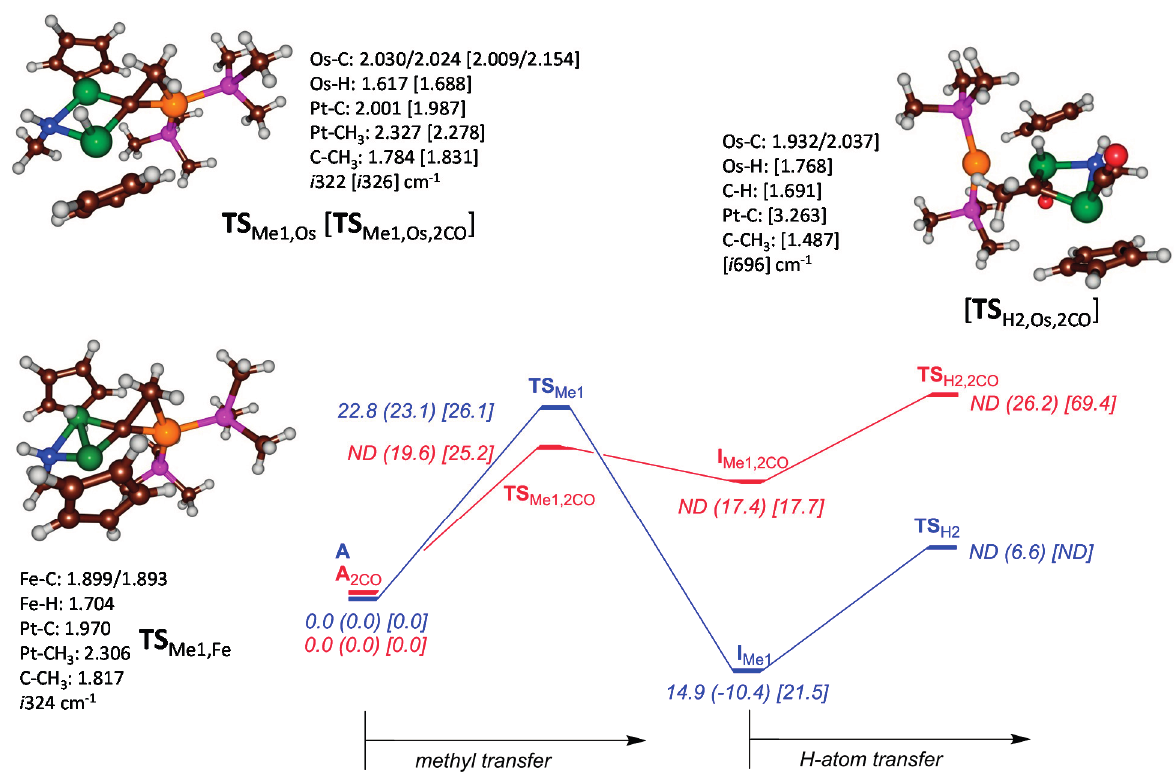
Figure 3. Potential energy landscape for ethylidene formation from complex A with initial methyl transfer followed by hydrogen transfer. All energies are obtained with UB3LYP/BS2 and contain zero-point and solvent corrections in kcal·mol − 1 . Optimized geometries of key structures are given with bond lengths in angstroms. ND stands for not determined. The blue surface represents the bare system without CO, whereas the red surface contains the CO bound complexes. Energy data is given for Fe (Ru) [Os]